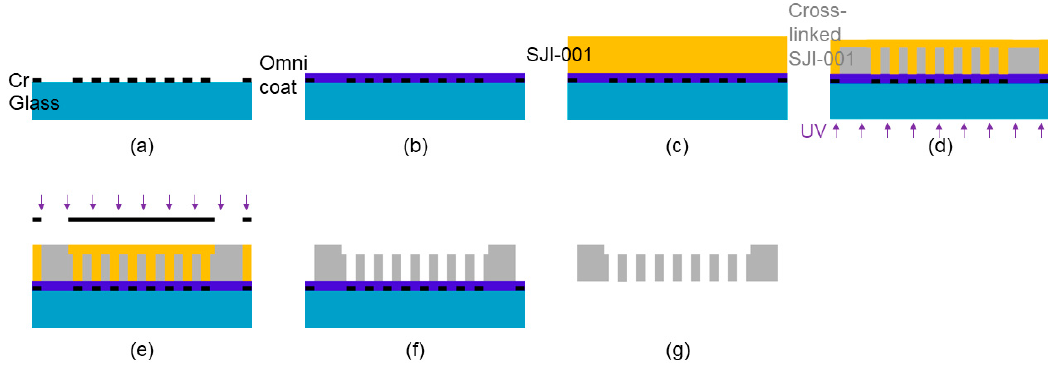
Figure 2. Schematic images of the fabrication process of cell culture plate having the porous 3D lattice structure. The cell culture plate was fabricated by double side exposure to a single SJI-001 layer. The porous or rough surface 3D lattice structure was fabricated via the same fabrication process, with a different exposure energy. ( a ) Spattering Cr layer. ( b ) Coating sacrificial layer. ( c ) Depositing SJI-001 layer. ( d ) Exposing from the back side of the glass substrate. ( e ) Exposing from the top side of the glass substrate. ( f ) Developing uncross-linked SJI-001. ( g ) Peeling off the cross-linked SJI-001.